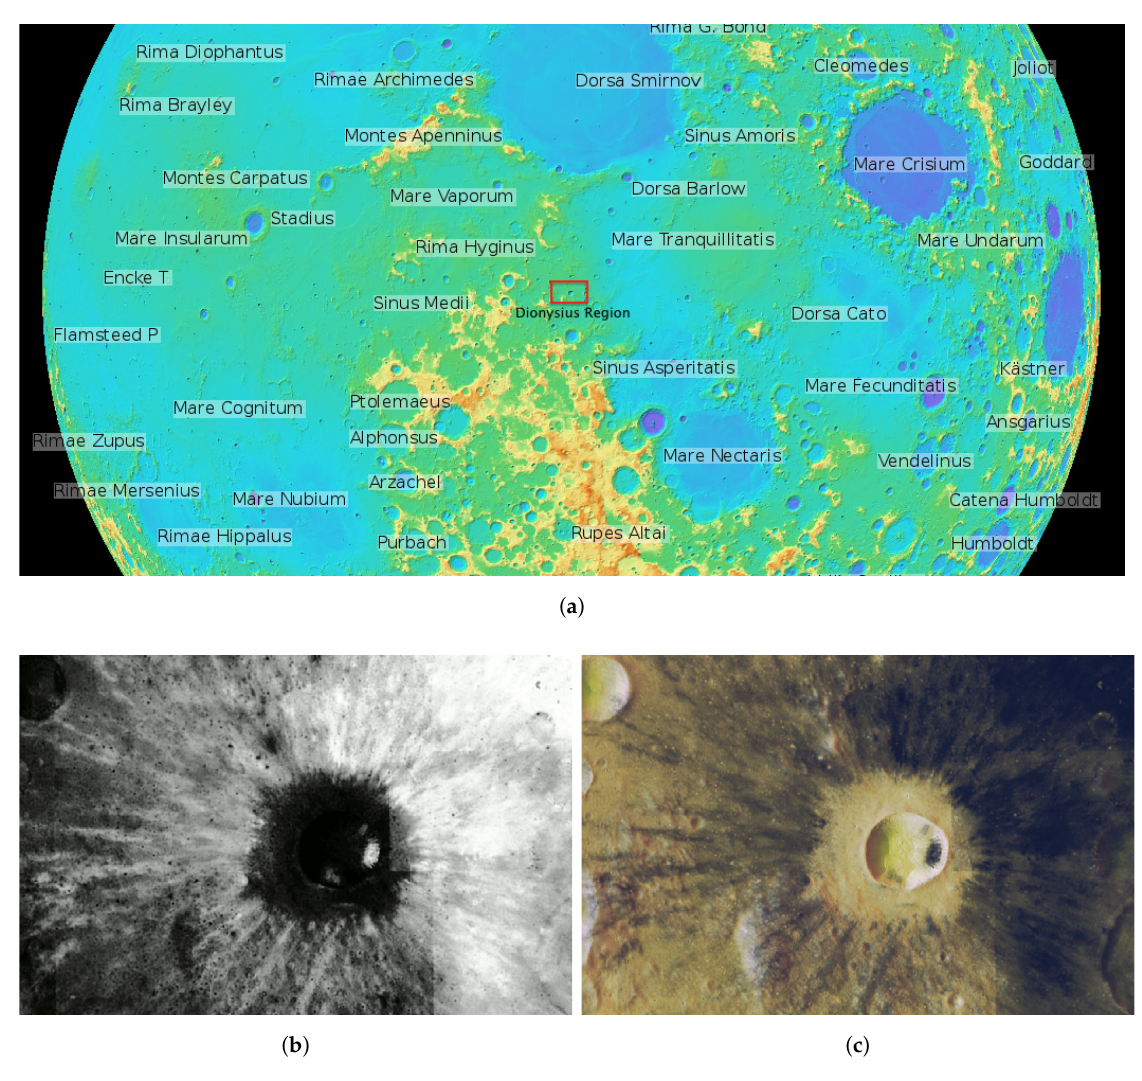
Figure 6. Dionysius region of interest with coordinate values S1.6 N4.2 and W15 E19 in degrees. ( a ) NASA’s Lunar Reconnaissance Orbiter (LRO) Wide Angle Camera (WAC) relief image in orthographic projection of the lunar near side and the Dionysius region in the center. Source: http://wms.lroc.asu.edu/lroc; ( b ) percentage of TiO 2 weight (wt%) using the Lucey et al. [57] method. Source: http://www.lpi.usra.edu/lunar/tools/clementine/; ( c ) the Dionysius region of interest with an overlay of TiO 2 percentage in black